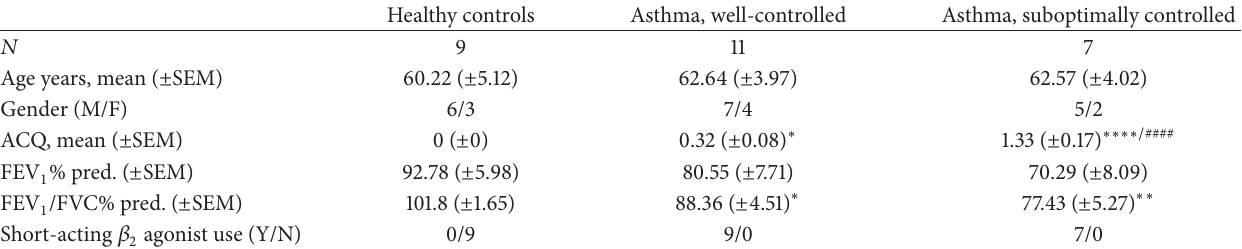
Table 1: Patient characteristics of healthy controls and